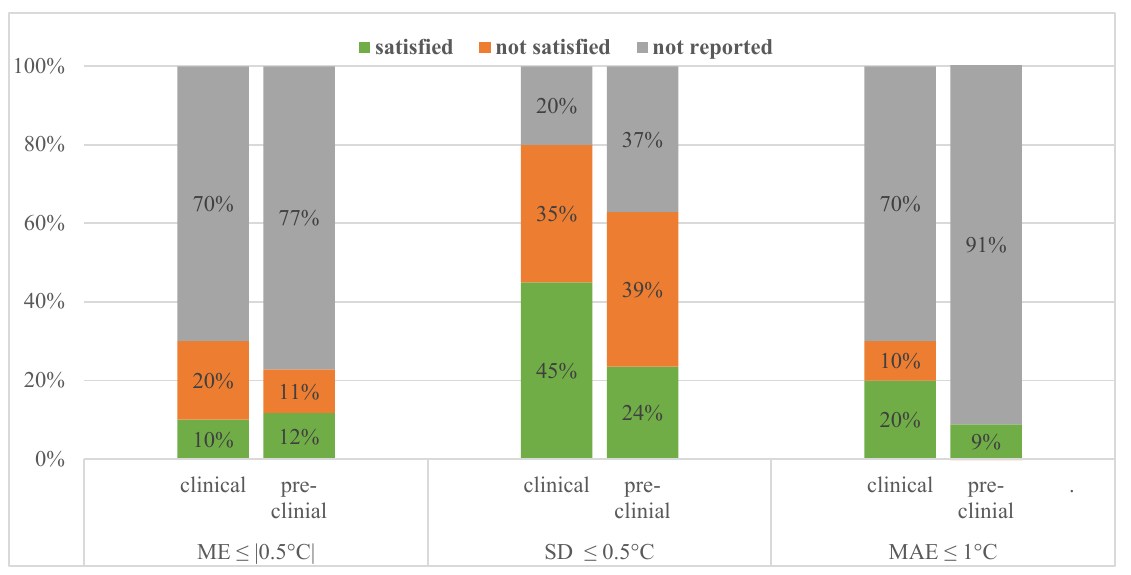
Figure 3. Performance values reported and how many of those satisfied our requirements for clinical and pre-clinical studies.